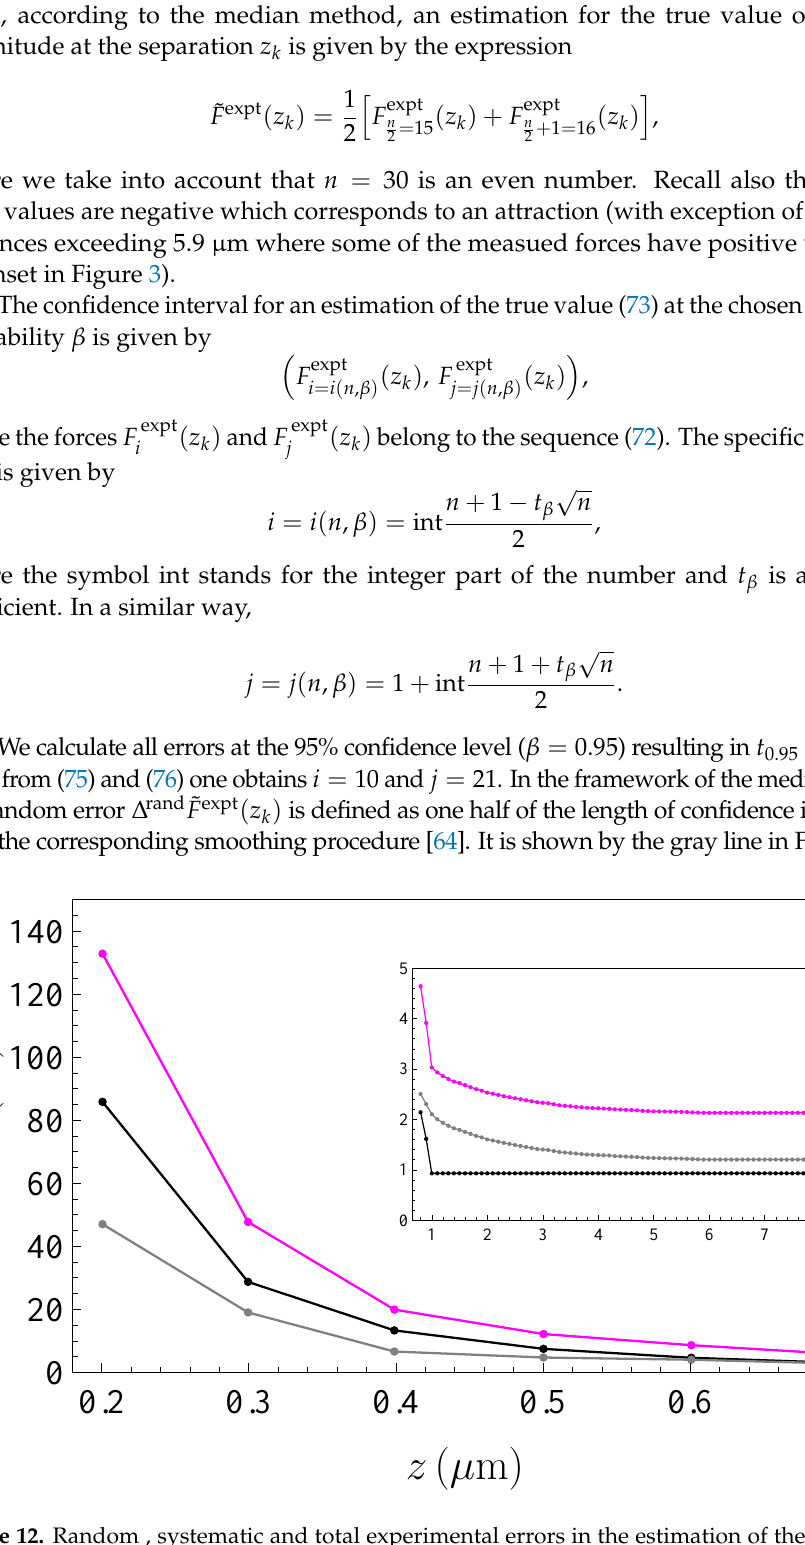
Figure 12. Random , systematic and total experimental errors in the estimation of the true values ˜ F expt ( z ) are shown by the gray, black, and pink dots, respectively, as functions of separation. The k separation interval from 0.7 to 8 µ m, where all errors vary relatively slowly, is shown in the